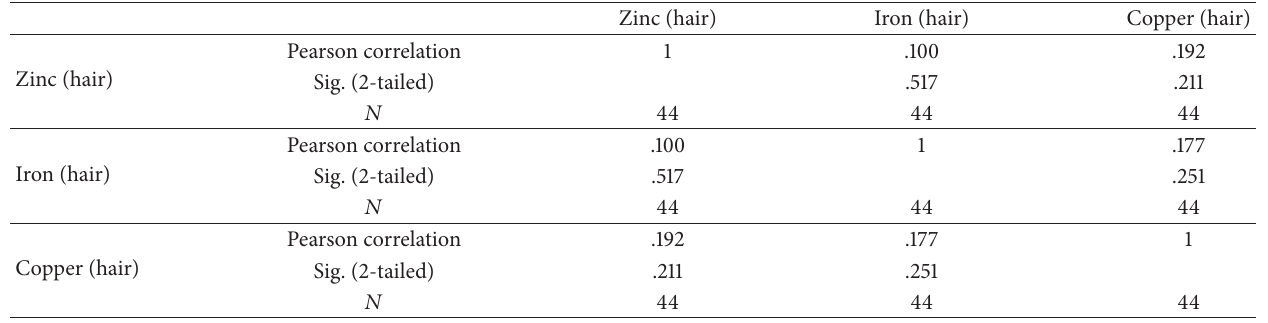
Table 3: Correlation between trace elements measured in hair.